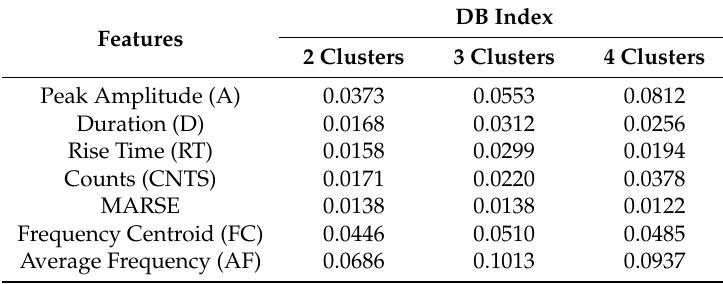
Figure 3. First interaction giving MARSE as the best feature of 2, 3, and 4 clusters. Table 2. DB index values at the first interaction for 2, 3, and 4 clusters.